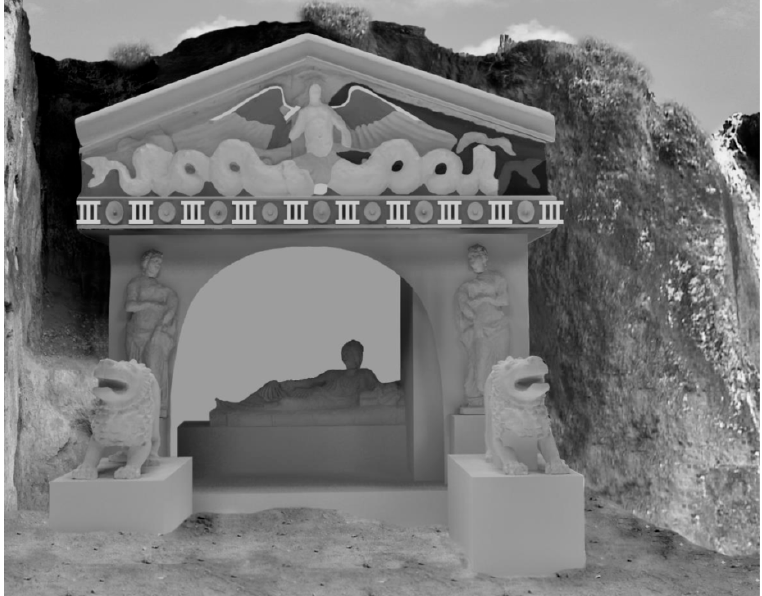
Figure 9. Rendering of the original architecture of the Tomba dei Demoni Alati based on laser scanning of the remains found in loco (graphic by Tecsette S.R.L., Florence, Italy).